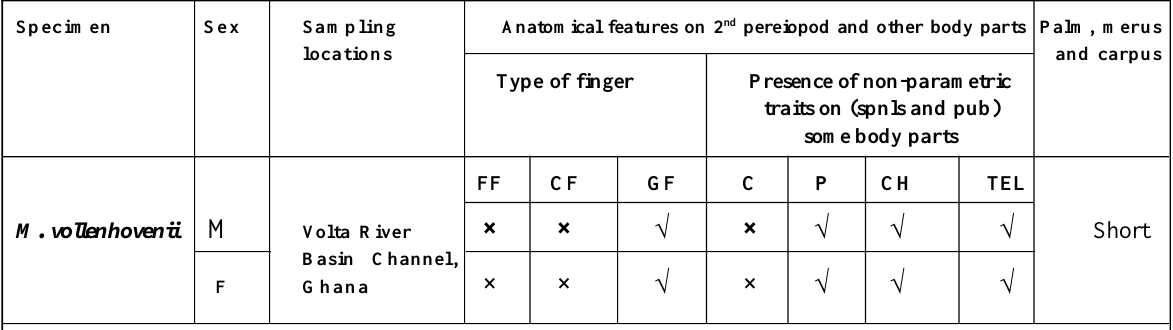
Table 2: Non-parametric traits indicators used in morphological characterization of M. vollenhovenii on the studied sections of lower volta river